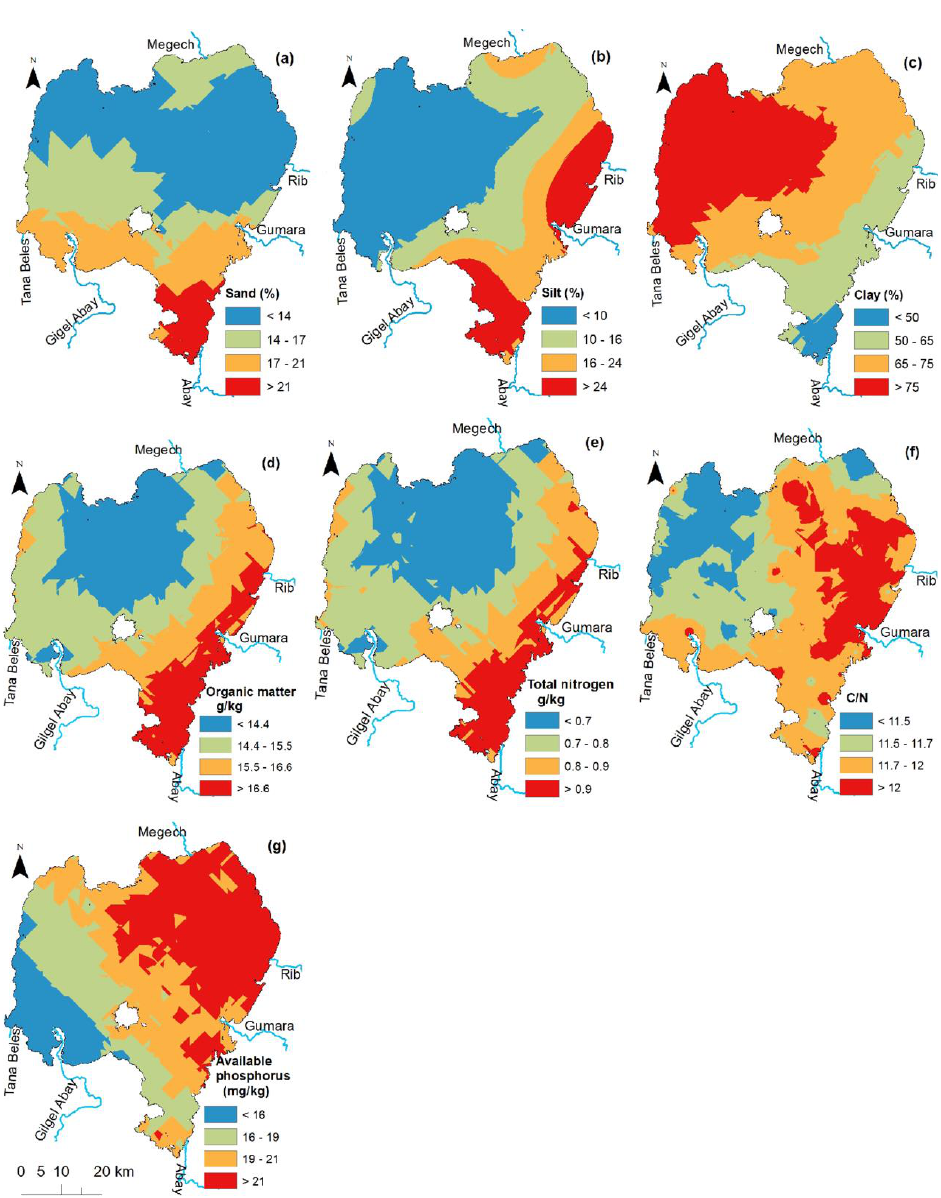
Figure 5. Bottom sediment characteristics of Lake Tana: Sediment composition; ( a ) sand, ( b ) silt, ( c ) clay percentages, ( d ) organic matter concentration of sediment, ( e ) total nitrogen concentration of sediment, ( f ) carbon to nitrogen ratio, and ( g ) available phosphorus concentration of the sediment.